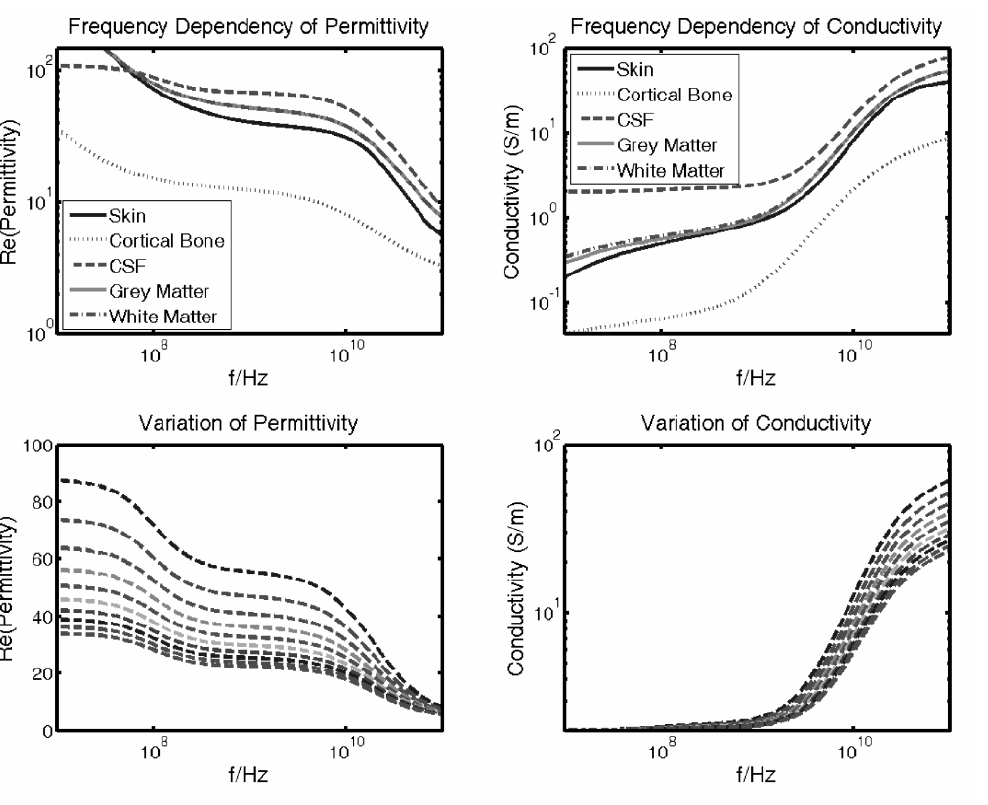
Figure 12. Two upper images : Frequency dependency of permittivity (real part:  ) and conductivity  of the different tissues forming the human head model. Two lower images Lower: Permittivity and conductivity variation of layer 3 representing the tumour (nine steps decreasing from  = 55 down to  = 22 at 1 1 9